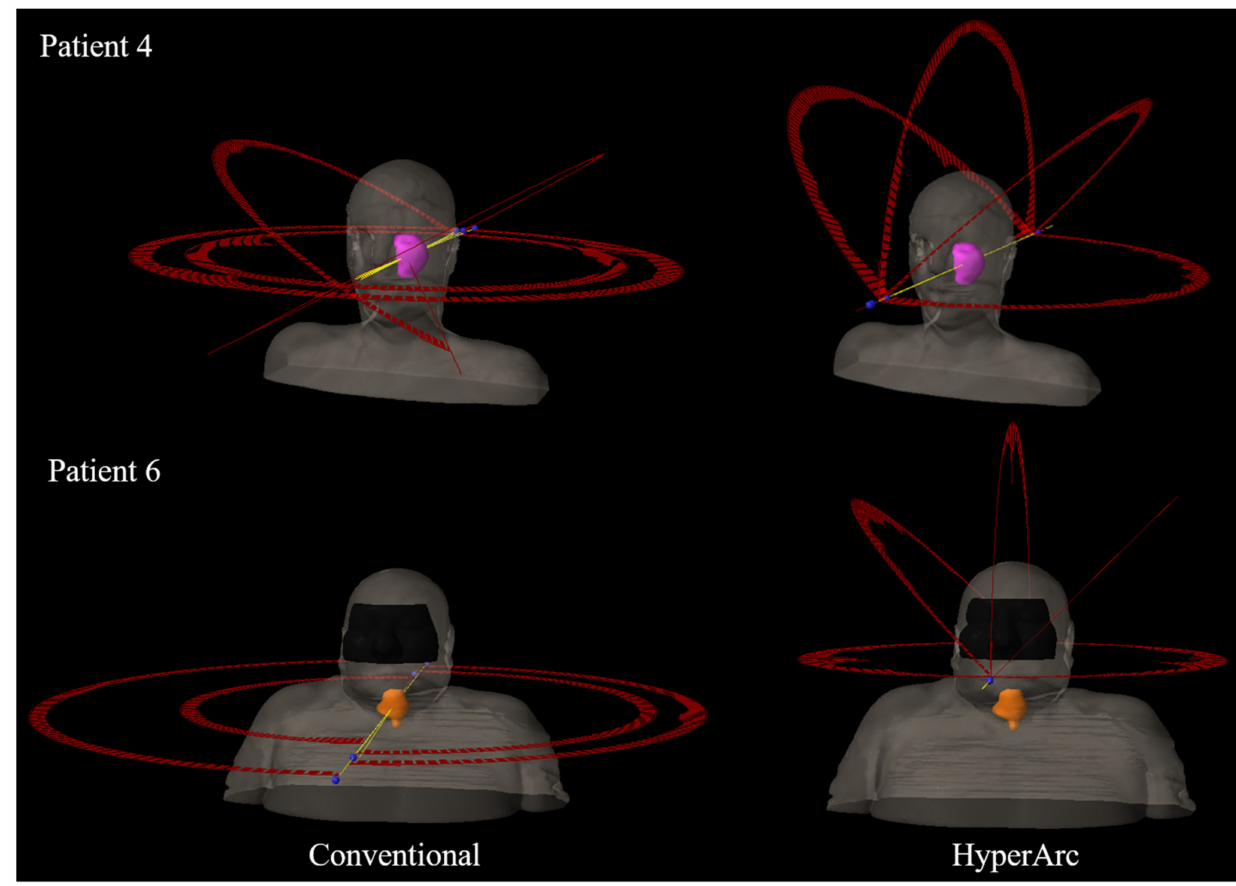
Figure 1. Beam arrangements for the conventional ( left ) and HyperArc ( right ) plans for two rHNC patients in this study. The PTV structures are shown in pink (Patient 4) and orange (Patient 6), and the yellow lines indicate the central axes for each